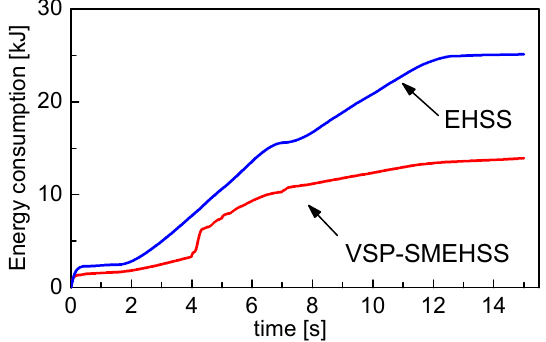
Figure 19. Total energy consumptions of the EHSS and the VSP-SMEHSS.